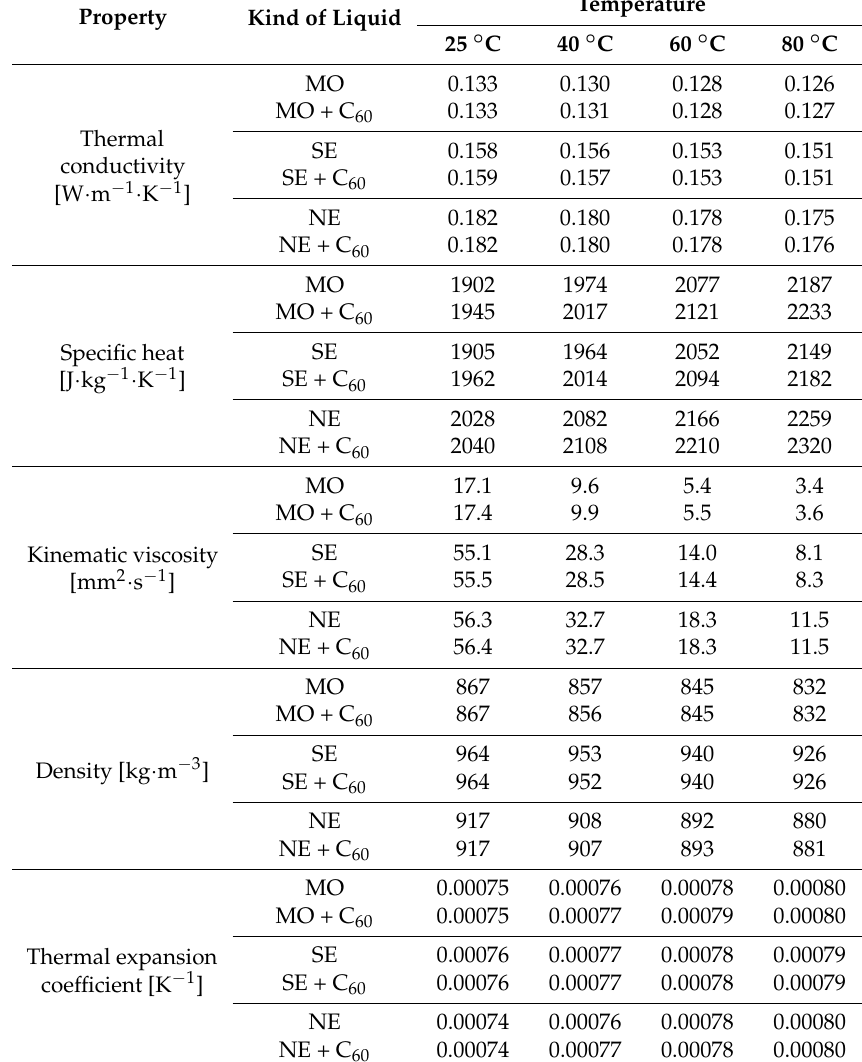
Table 3. Thermal properties of pure electro-insulating liquids and nanofluids based on fullerene C 60